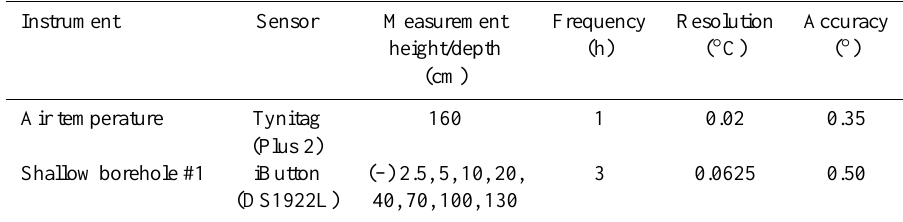
Table 1. Location and characteristics of the sensors installed at the Limnopolar Lake CALM site used here for the thermal characterization of the active